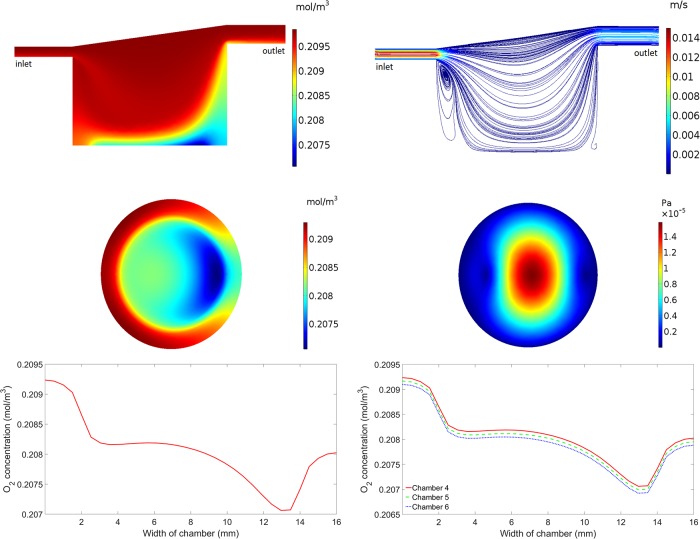
Simulation results for cells on top of the 9mm insert.Upper left: Oxygen concentration in chamber 4. Upper right: Flow profile in chamber 4. Middle left: Oxygen concentration at the base of chamber 4. Middle right: Magnitude of the shear stress at the base of chamber 4. Lower left: Oxygen concentration across the centre of the base of chamber 4. Lower right: Oxygen concentration across the centre of the base of chambers 4, 5 and 6.